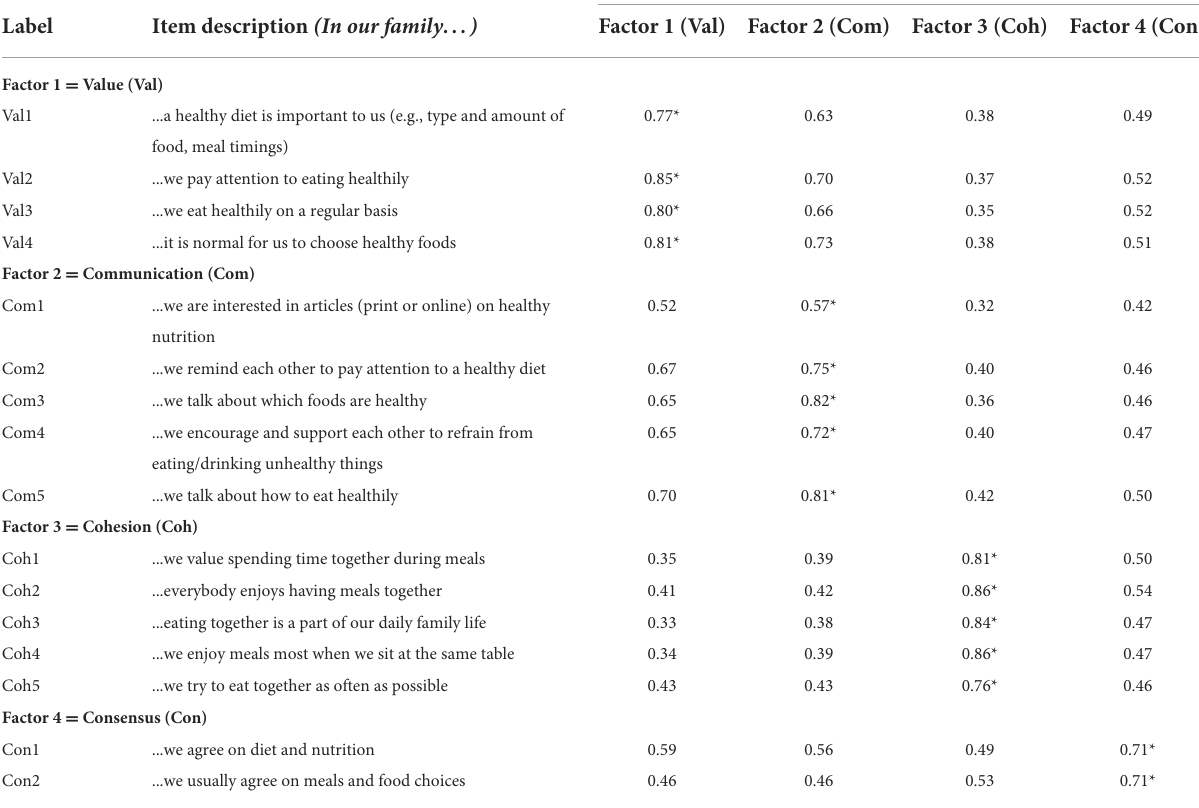
TABLE 5 Item-total correlations of FHC-NU (Sg) scale. FHC-NU (Sg) Item-total correlations Label Item description (In our